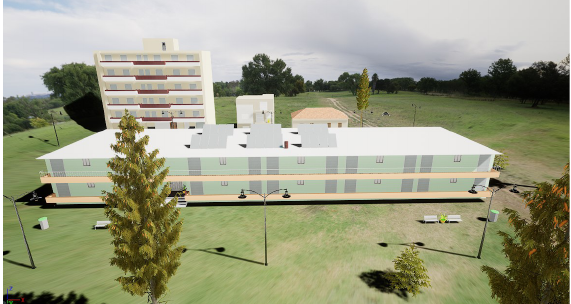
Figure 6. The BIM of the test building on top of a panoramic photo of the wider area